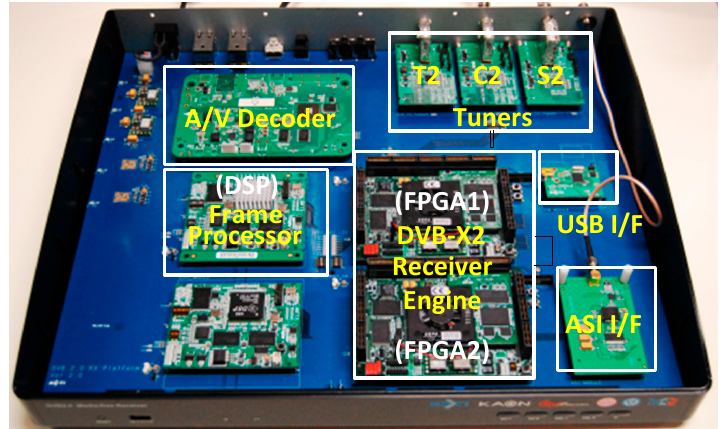
Figure 14. Implementation of the proposed DVB-X2 receiver. Table 3. Implementation results for the DVB-X2 receiver engine.